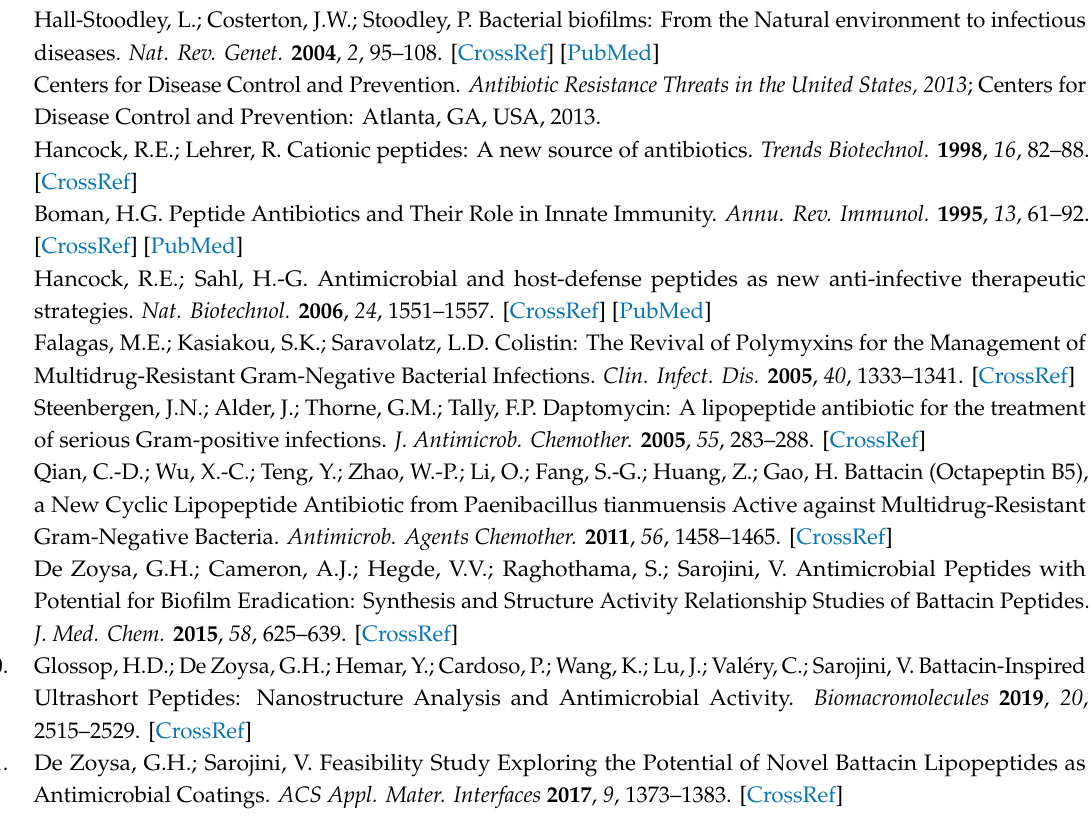
Figure S2: Sheer thinning experiment of methanol gels, Figure S3: Sheer thinning experiment of hydrogels, Figure S4: FT-IR spectrum of hydrogels prepared in water, Figure S5: biofilm assay graph, Figure S6: MTT viability assay of the